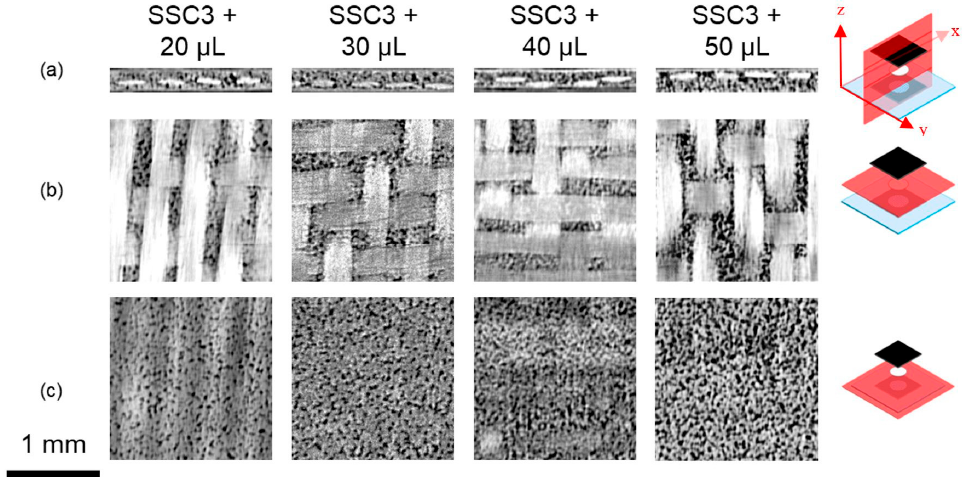
Figure 5. XµCT cross-sections of SSC3, showing the effect of increased EMIm TFSI IL loading on the porous ionogel microstructure with ( a ) cross-section taken through the x-z plane, while ( b , c ) show cross-sections taken through the x-y planes at the centre of the glass layer and at the glass layer/CNT electrode interface, respectively. The x-y-z orientation and section location are indicated at the right-hand side.